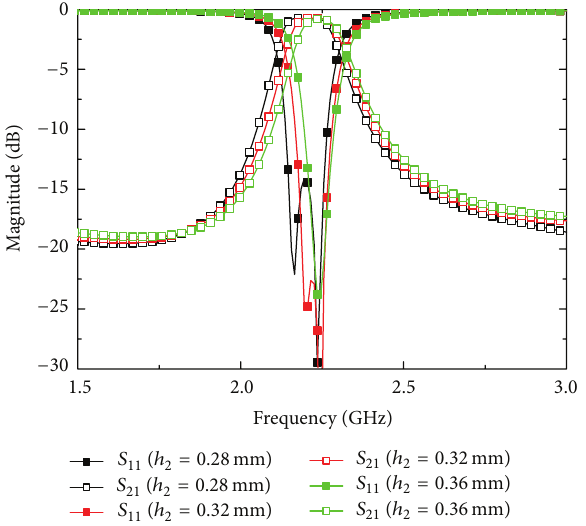
Figure 6: Simulated frequency response relative to changes in the number of the metal walls.